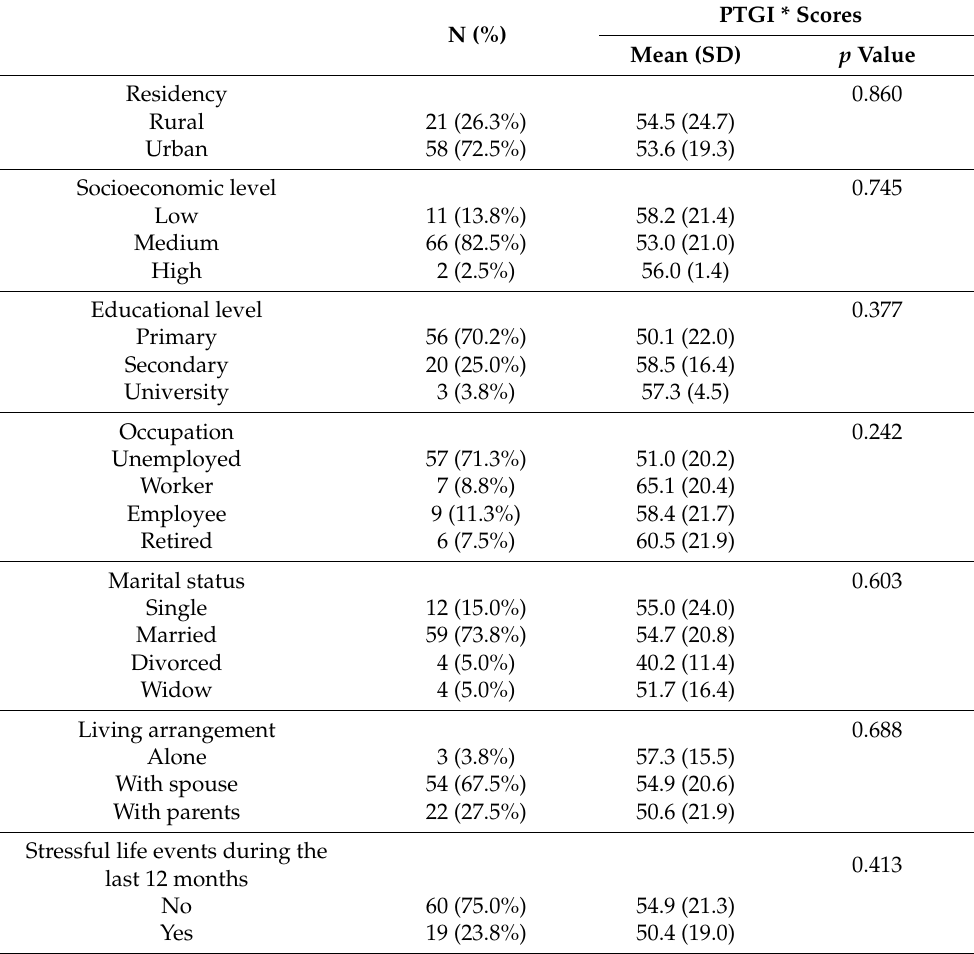
Table 1. Sociodemographic and clinical characteristics of participants ( n =